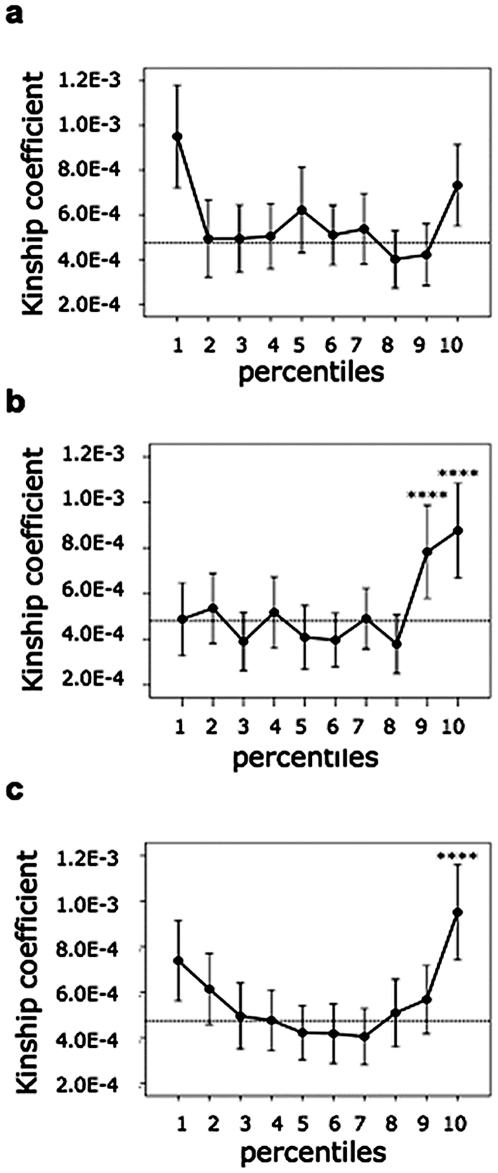
Clustering of extreme values for cholesterol HDL (a), triglyceride (b) and waist circumference (c): percentiles were constructed as described in the text, to account for the effect of sex and age.Kc was calculated within each percentile and the distribution was analyzed with ANOVA. Extreme percentiles were compared to the rest of the population and a p-value was calculated with the Mann-Whitney U Test: **** p-value <0.0005.